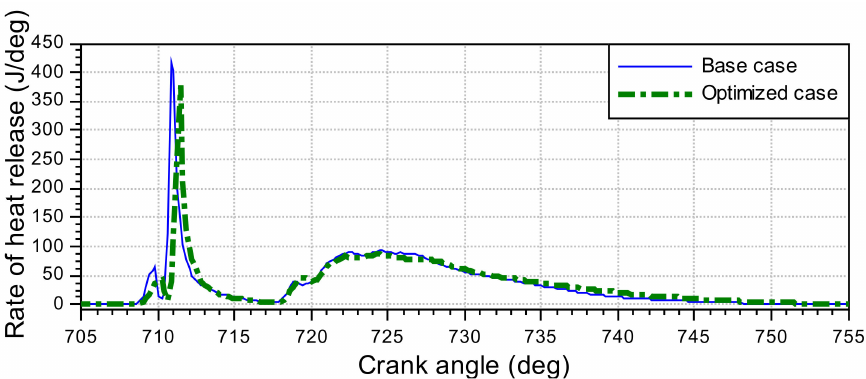
Figure 24. The rate of heat release curve for the optimal three-stage injection strategy compared to the base